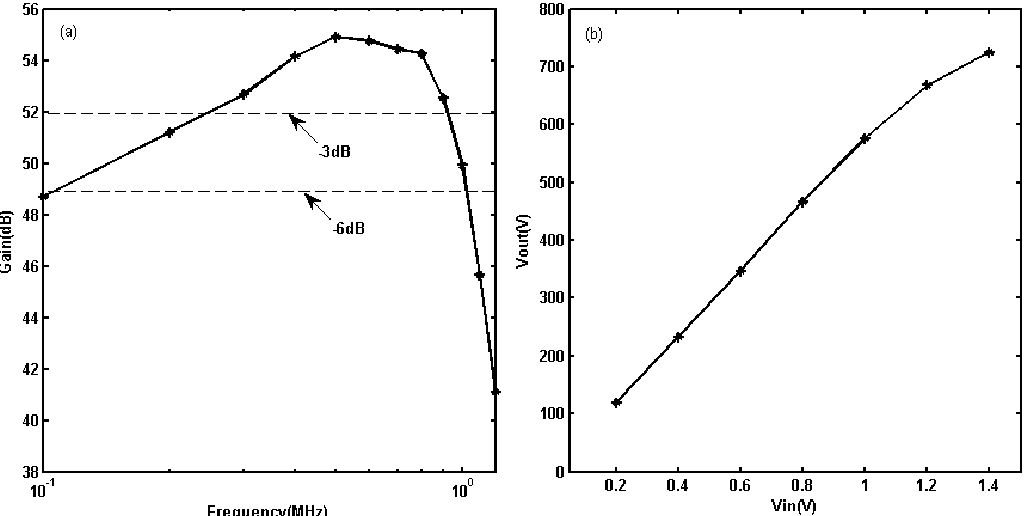
Figure 8. Evaluation of the proposed linear PA without feedback: ( a ) gain distribution from 100 kHz to 1.2 MHz; ( b ) Output voltages with increased input voltages at 500 kHz. 1.2 MHz; ( b ) Output voltages with increased input voltages at 500